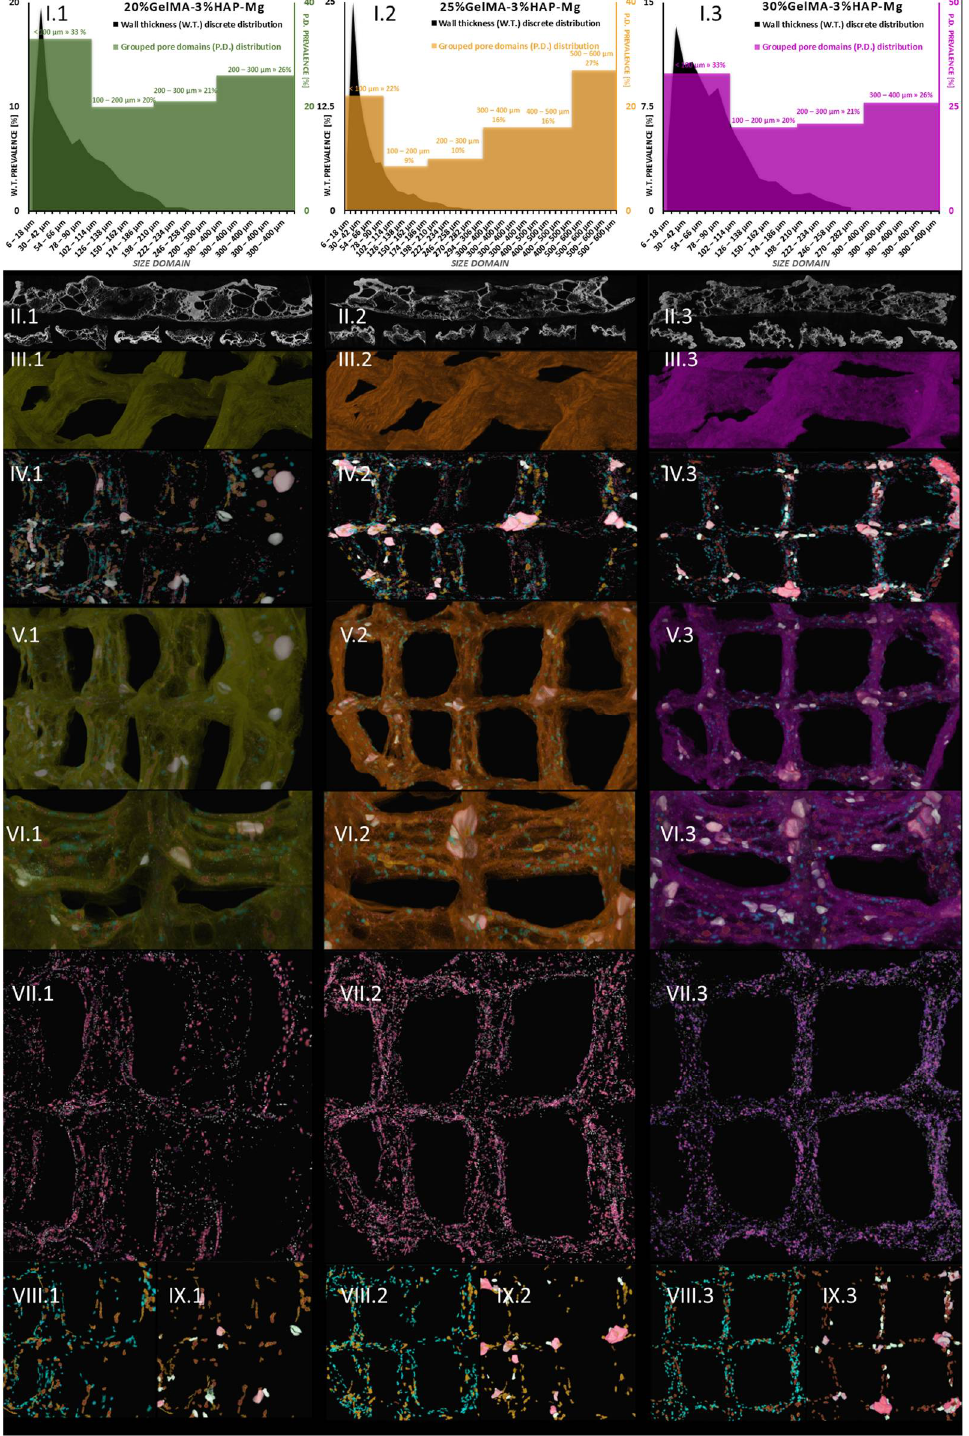
Figure 15. Micro-CT images of: (1 green) 20%GelMA-3%HAP-Mg, (2 orange) 25%GelMA-3%HAP- Mg, and (3 purple) 30%GelMA-3%HAP-Mg 3D printed composites. A quantitative analysis was performed using CTAn software to measure the solid and porous features of the prints. Figure 14(I) illustrates the charted data calculated. Discrete wall thickness incidence values were plotted against their size domains in micrometers and were superimposed with the incidence of pore domains, grouped in three spans: <100 µm, 100–200 µm, >200 µm. In Figure 14(II) subdivisions, we illustrated representative 2D sections from the tomogram, where a clear separation between the object and the pores